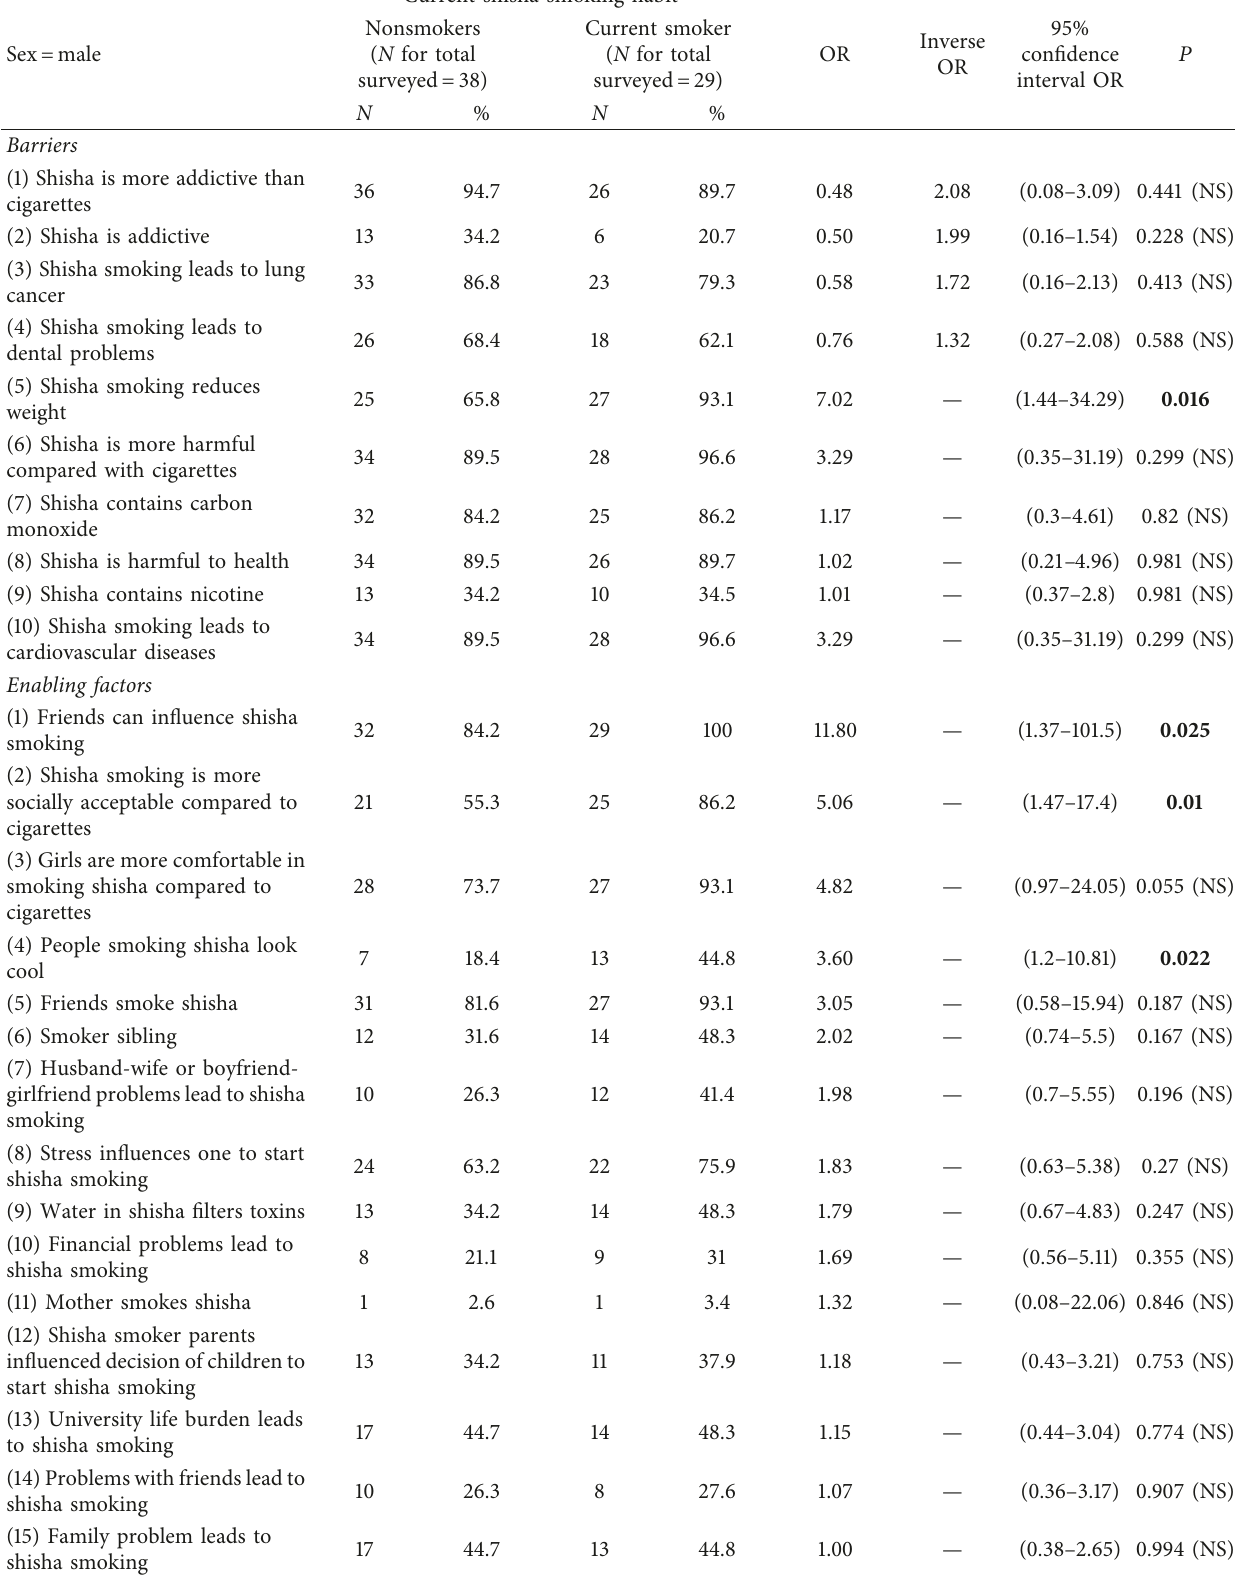
Table 10: The strength of association between selected barriers and enabling factors with current shisha smoking habits among males.